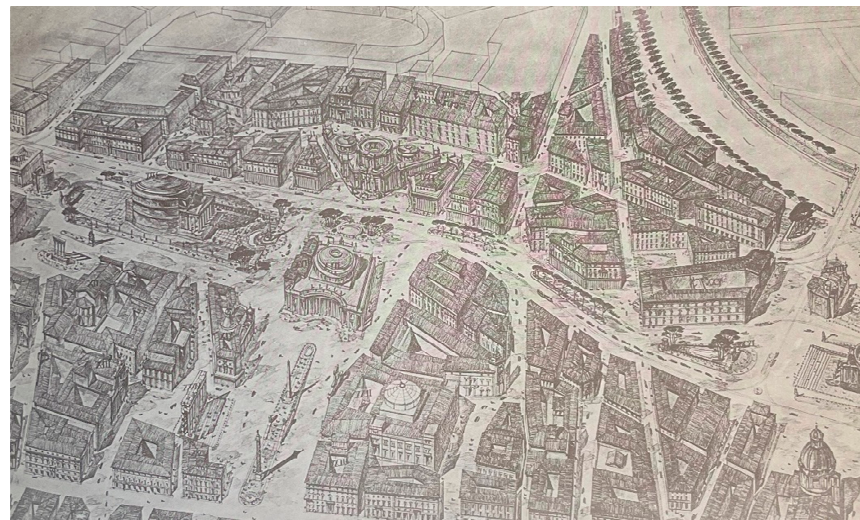
Figure 10. Armando Brasini, 1925, Birds Eye view of Forum of Mussolini and Via Imperiale from Tomb of Augustus to Pantheon—Published in Capitolium, vol. 3, 1927-28.” In Armando Brasini: Roma Imperiale. Edmonton: Edmonton Art Gallery, 1978. Exhibition catalogue. Image courtesy of the Art Gallery of Alberta. The church of St Ignatius is on the bottom left, facing the columns of Hadrian’s temple.